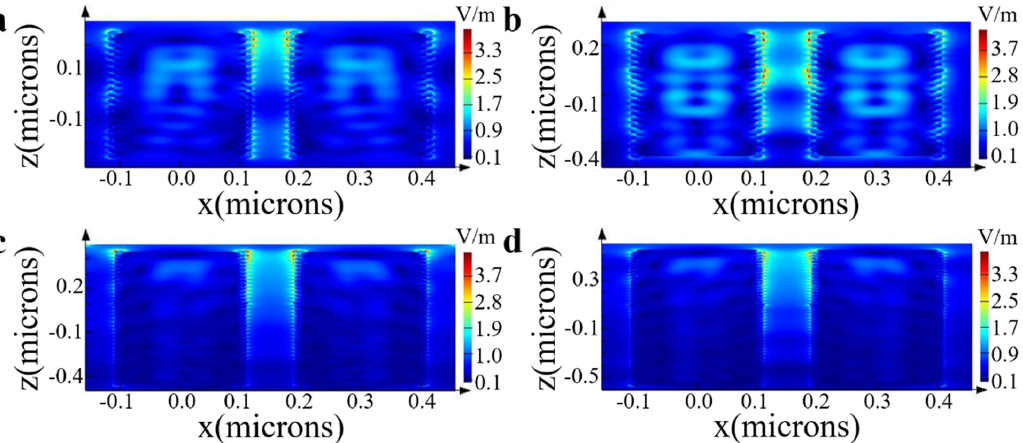
Figure 1. Distribution of the FDTD − simulated near − field electrical intensity in the wavelength of 785 nm with different SiNRs’ length. ( a ) 500 nm, ( b ) 700 nm, ( c ) 900 nm and ( d ) 1100